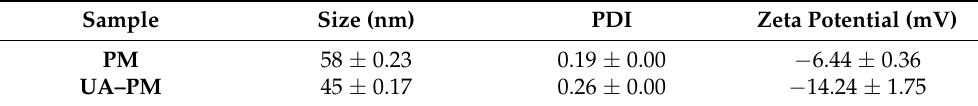
Table 1. Physical and chemical characterization of empty (PM) and UA-loaded polymeric micelles (UA–PM). Data are reported as mean ± SD of n = 3 experiments.